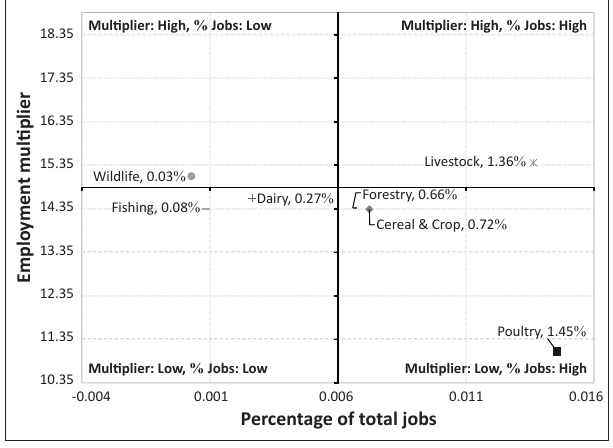
FIGURE 7: Employment multipliers versus percentage labour contribution.